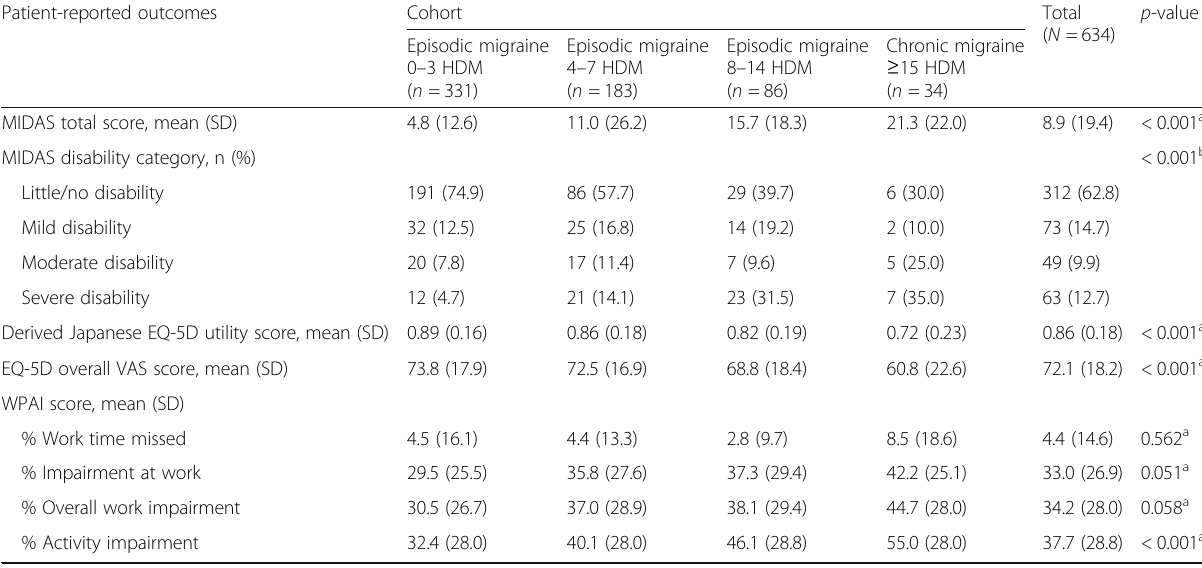
Table 4 Burden of illness in patients with episodic migraine and chronic migraine: patient self-completion form data Patient-reported